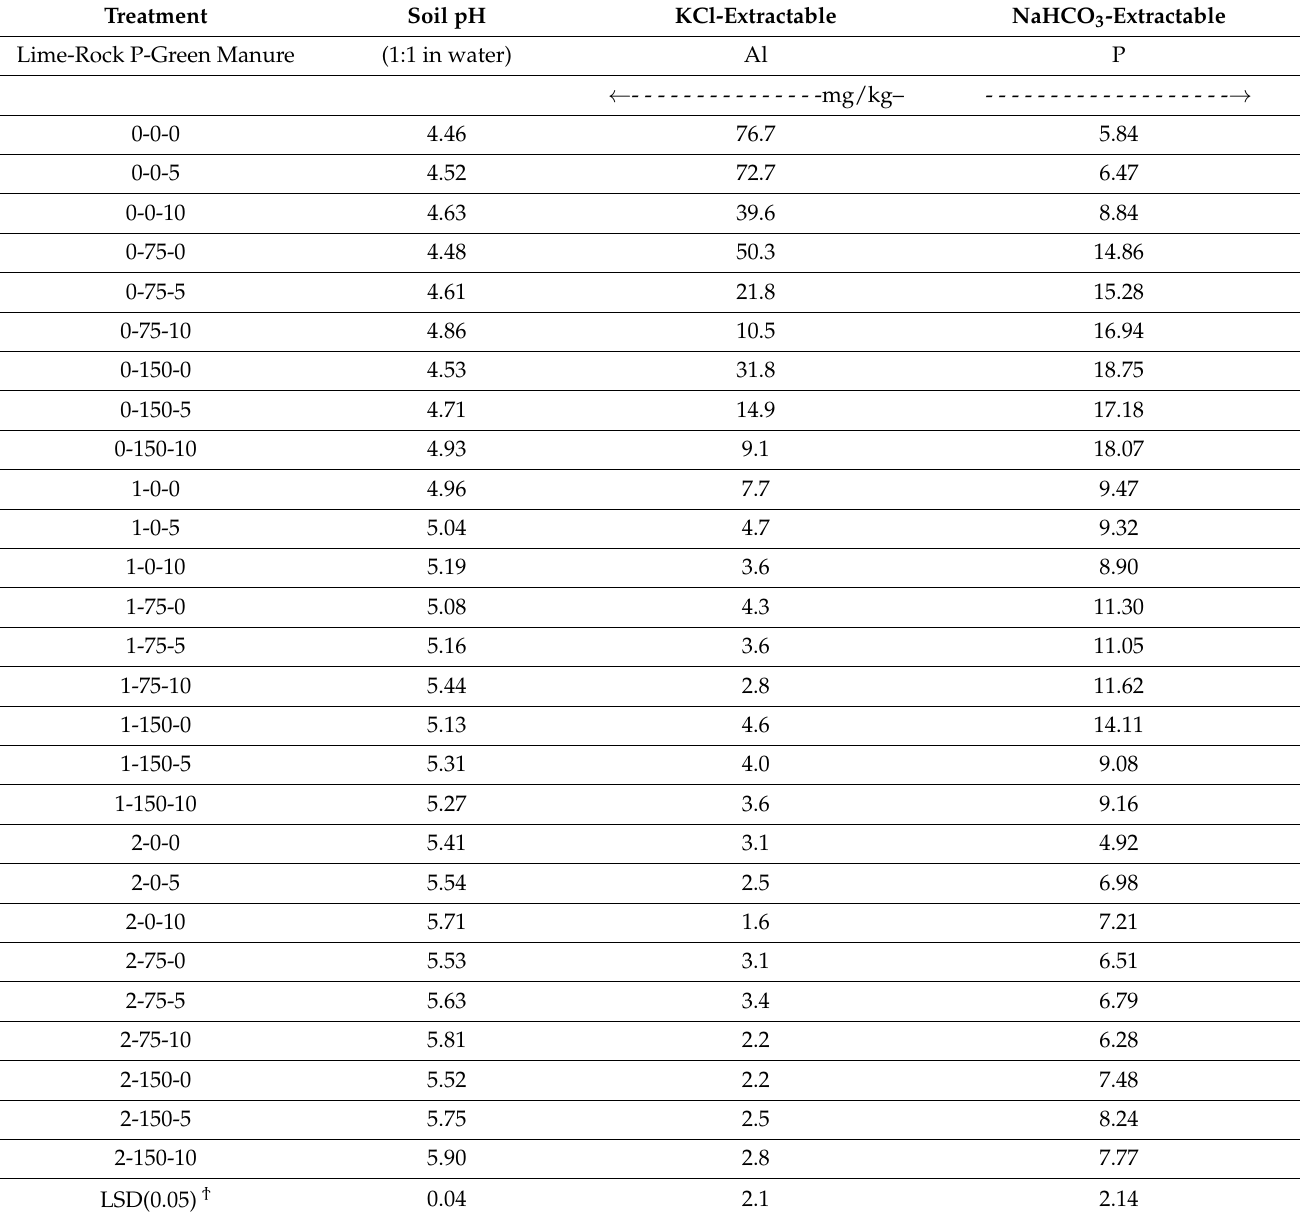
Table 2. Soil pH, KCl-extractable Al, and NaHCO 3 -extractable P in an acid Oxisol as affected by lime, rock phosphate and green manure amendments.